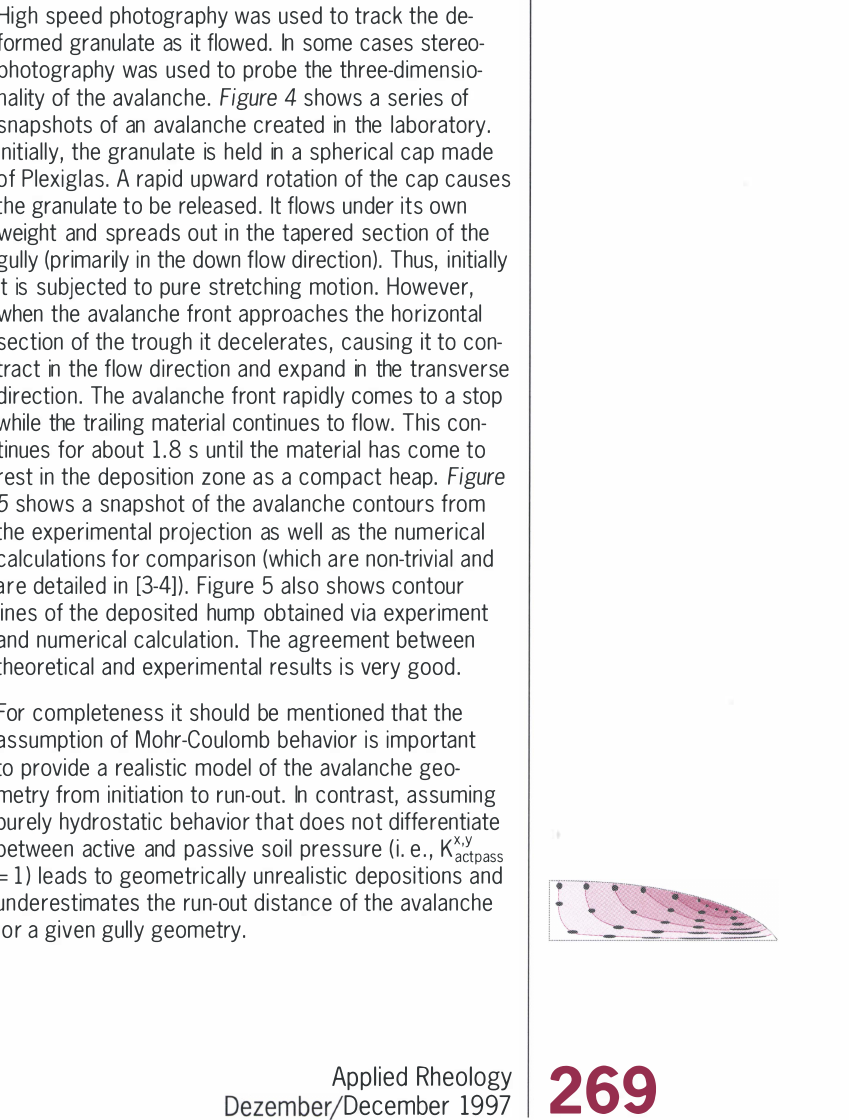
Fig. 4: Series of photos of experi­ ments with quartz sand on a gully that is slightly curved in the lateral direction. The gully expands into a plane at the bottom. (Photos: M.